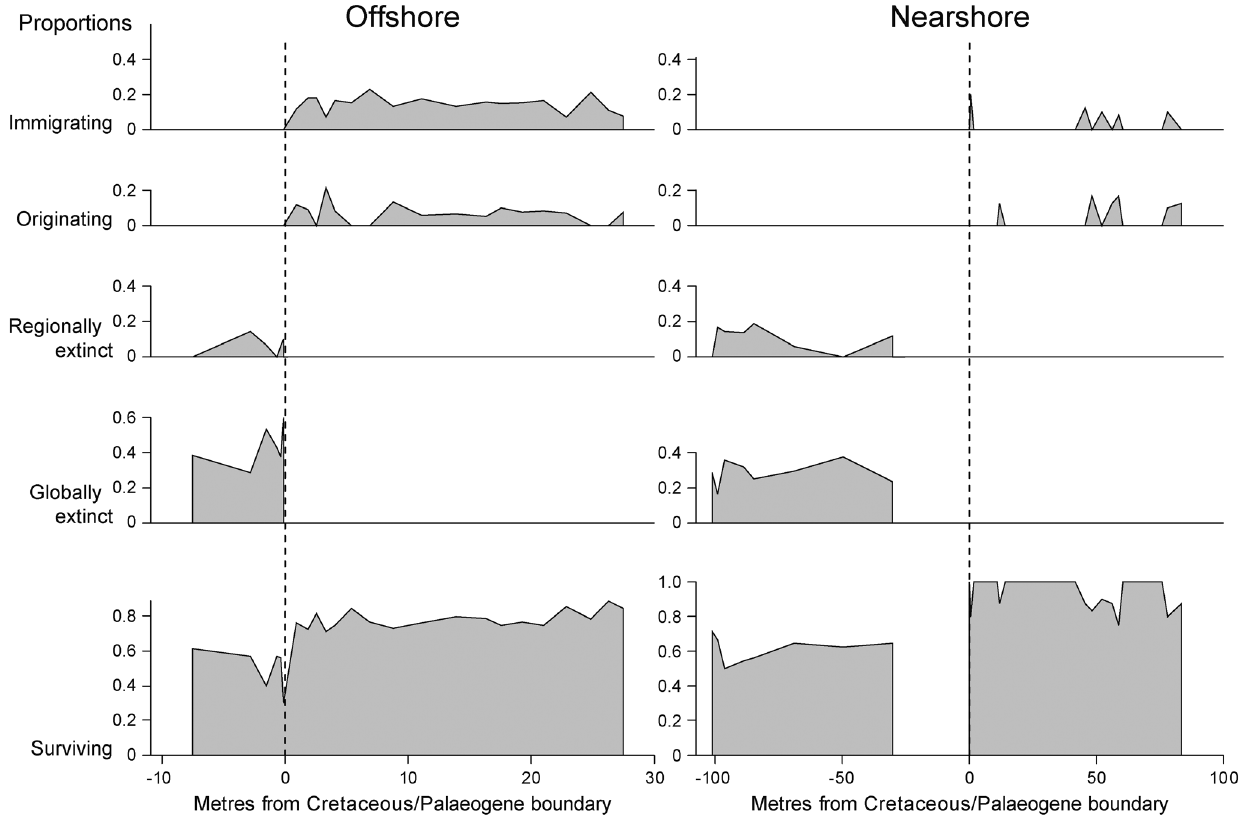
Figure 3. Proportional diversity of molluscan genera in five evolutionary/biogeographical categories across the Cretaceous- Palaeogene boundary. Proportions are shown for an offshore (panels on the left) and a nearshore boundary section (panels on the right) in Patagonia. Dashed vertical lines indicate position of the Cretaceous-Palaeogene boundary; values on x-axis refer to metres before (Cretaceous, negative values) or after the boundary. Nearshore, the uppermost ca 26 metres of the Cretaceous are characterised by low-diversity brackish-water assemblages, which are not included in the figure. Post-extinction faunas are dominated by survivors. Immigrating and originating genera play subordinate roles in the composition of Danian samples.